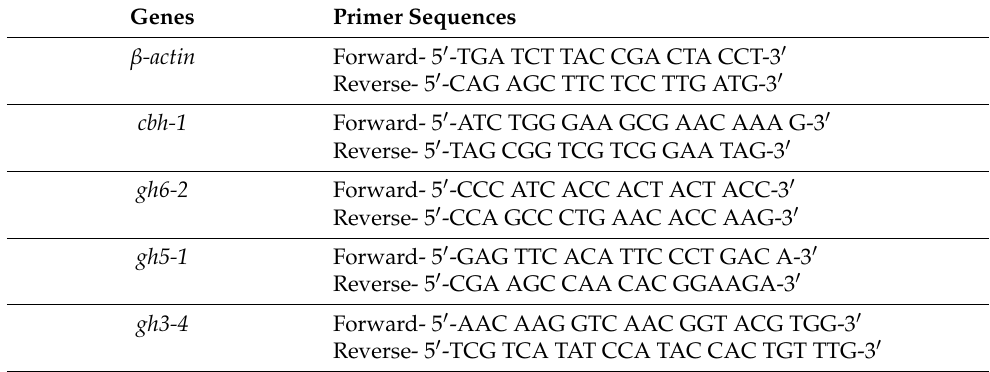
Table 1. List of primers used in qRT-PCR. Genes Primer